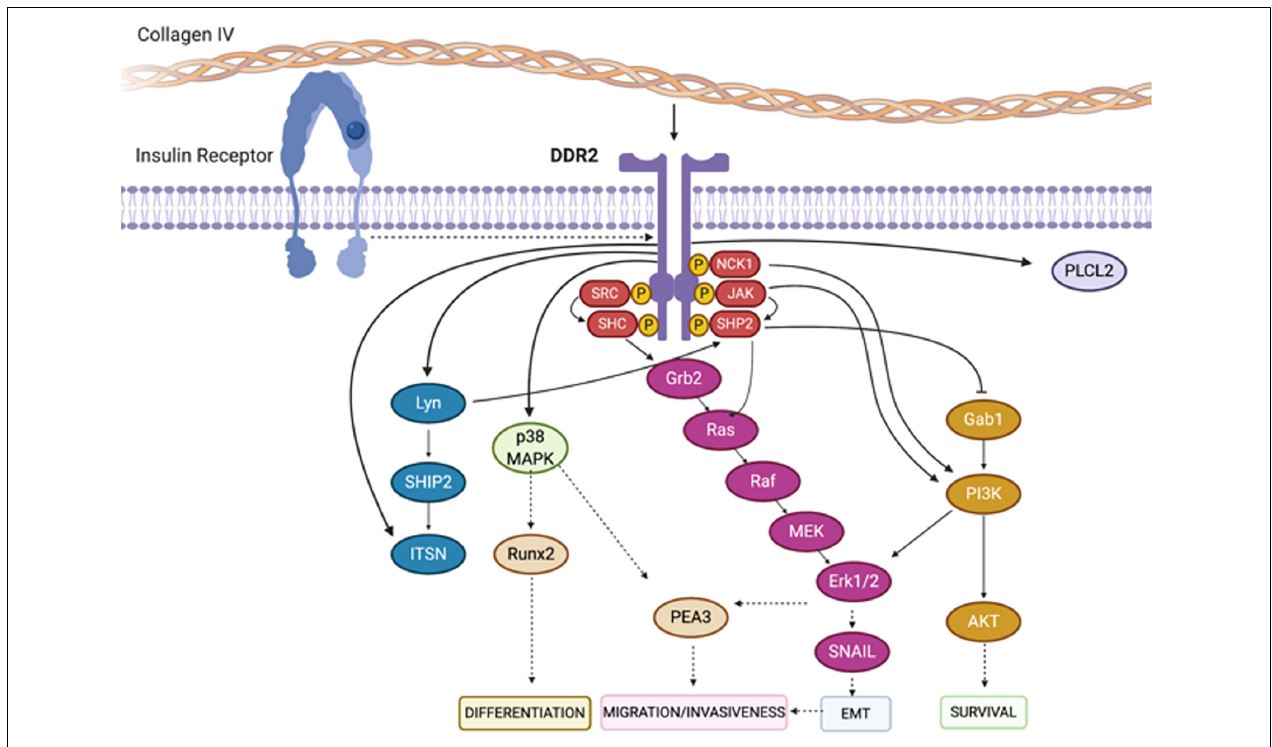
FIGURE 7 | Depiction of signaling pathways activated downstream of DDR2. Binding of collagen to the extracellular domain of DDR2 triggers the auto-phosphorylation of its cytoplasmic domain. This results in the recruitment of downstream adaptor proteins, kinases and phosphatases including SHC, NCK1, SRC and SHP-2. As a consequence, a series of canonical signaling pathways are initiated including the Erk1/2 and PI3K cascades. Figure adapted and modified from Payne and Huang (2014) and Jing et al.